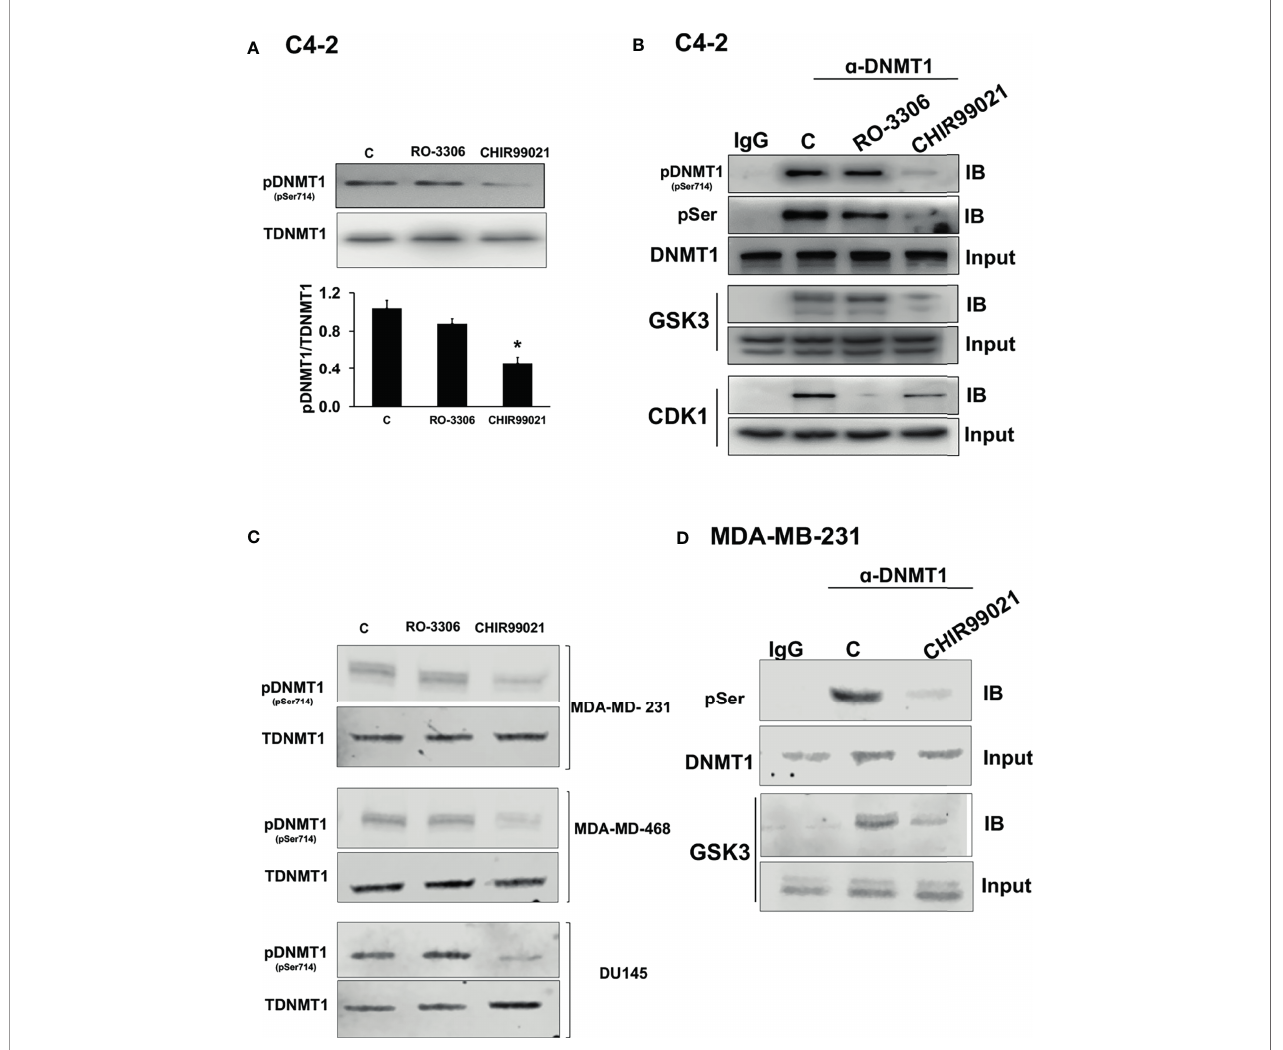
FIGURE 1 | Regulation of the levels of phosphorylated DNMT1 (S714). (A) Immunoblot analysis of phosphorylated DNMT1 (S714) in C4-2 cells treated with either CHIR99021 (4 µM) or RO-3306 (1 µM) for 4 h *P<0.05 vs . Control. Figures are representative of at least 3 independent experiments. (B) C4-2 cells were treated with either RO-3306 (4 µM) or CHIR-99021 (4 µM) for 4h to inhibit CDK1 and GSK3, respectively. Cell extracts were immunoprecipitated with DNMT1 prior to immunoblot analyses of pDNMT1 (S714), phosphorylated serine (pSer), DNMT1, GSK3, and CDK1. (C) Immunoblot analysis of phosphorylated DNMT1 (S714) in MDA-MB-231, MDA-MB-468, and DU145 cells treated with either CHIR99021 (4 µM) or RO-3306 (1 µM) for 4 h (D) MDA-MB-231 cells were treated with CHIR-99021 (4 µM) for 4 h to inhibit GSK3. Cell extracts were immunoprecipitated with DNMT1 prior to immunoblot analyses of phosphorylated serine